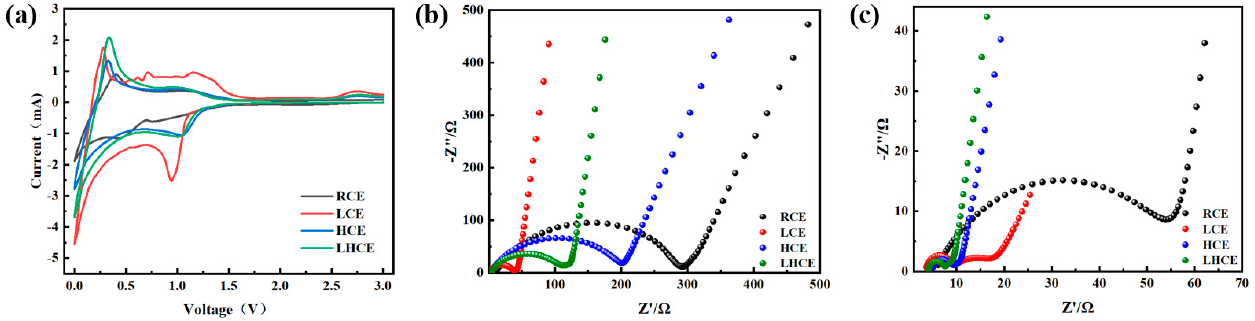
Figure 3. ( a ) First CV cycle of Li||C batteries in four electrolytes. EIS analysis of Li||C batteries before ( b ) and after ( c ) three cycles of